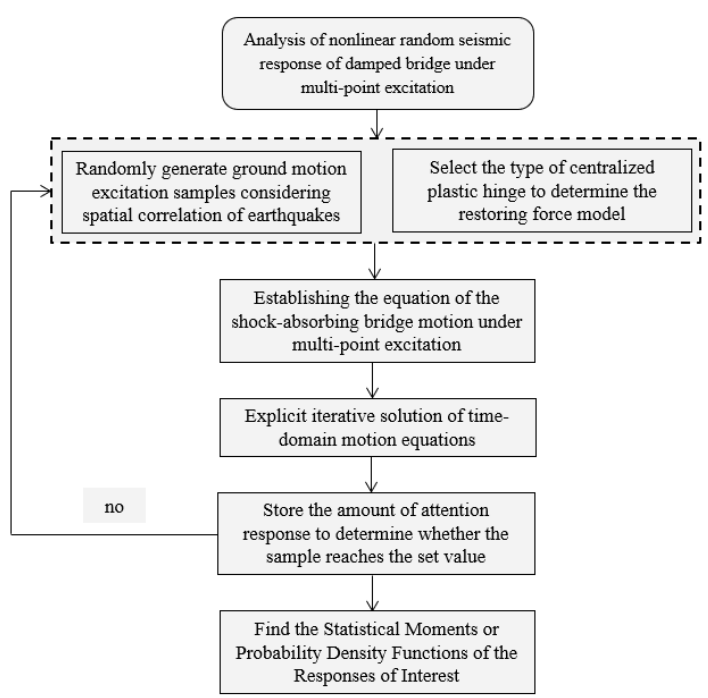
Figure 3. Flowchart of the solving process for the hysteretic variable through iterative calculations.